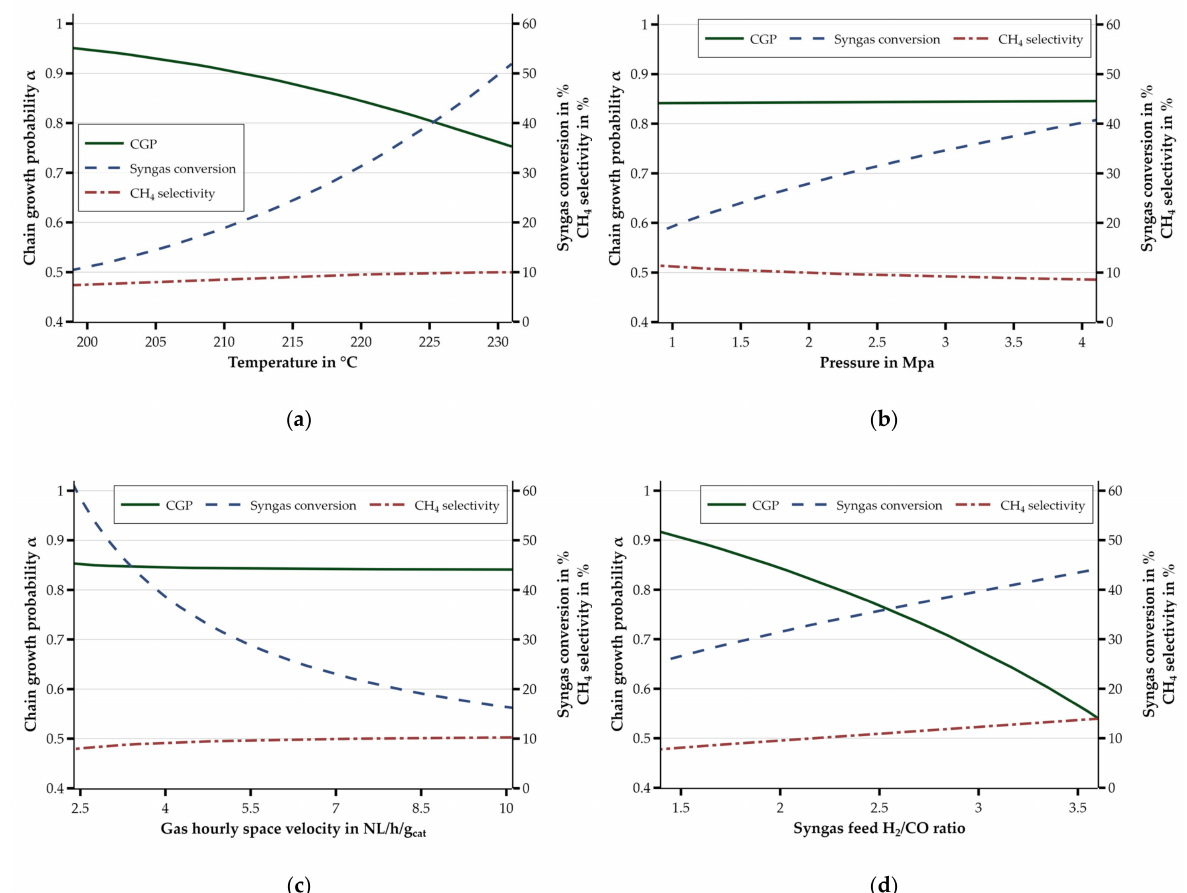
Figure 4. Key parameters of the FT reactor calculated on the basis of the model showing ( a ) the temperature-dependency for a fixed-bed-reactor with p = 2.5 MPa, gas hourly space velocity (GHSV) = 5 NL/h/g cat , and H2/CO syngas feed ratio = 2; ( b ) the pressure-dependency for a fixed bed reactor with T = 220 ◦ C, GHSV = 5 NL/h/g cat , and H2/CO syngas feed ratio = 2; ( c ) the dependency from the GHSV for a fixed-bed-reactor with T = 220 ◦ C, p = 2.5 MPa, and H2/CO syngas feed ratio = 2; and ( d ) the dependency on the H2/CO syngas feed ratio for a fixed bed reactor with T = 220 ◦ C, p = 2.5 MPa, and GHSV = 5 NL/h/g cat